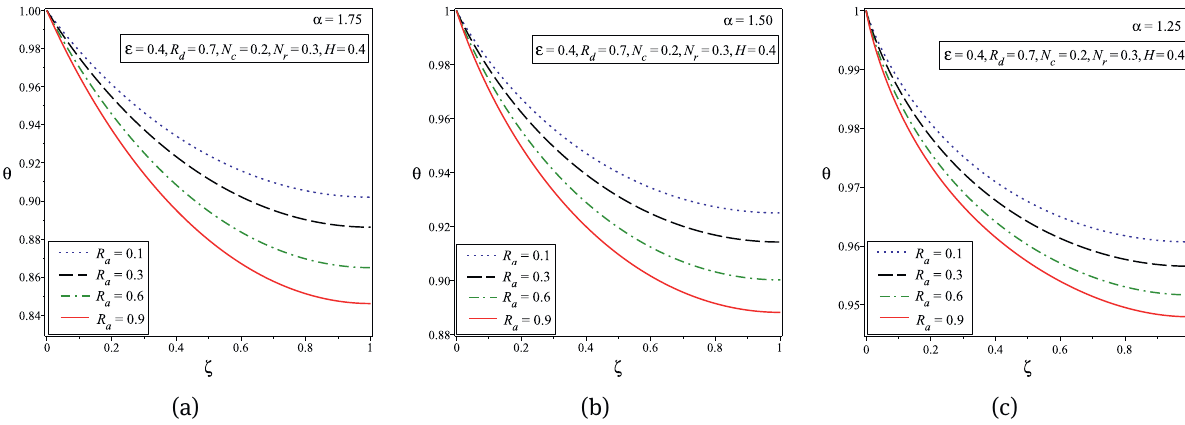
Fig. 9: The ADSTM solutions for a different value of R a and for (a) α = 1.75 (b) α = 1.5 (c) α = 1.25 .